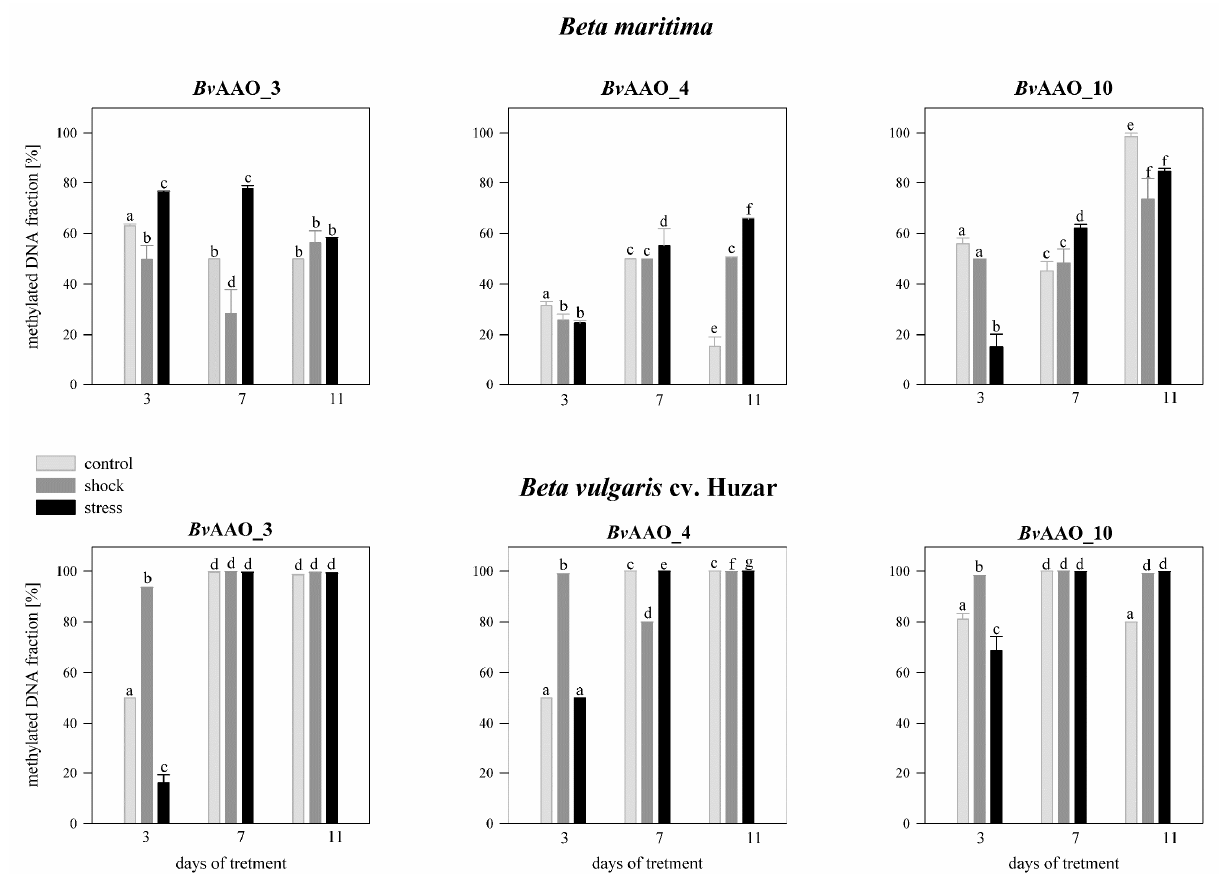
Figure 7. Methylated DNA fraction [%] of CpG islands in the promoter region of AAO genes Bv AAO_3, Bv AAO_4 and Bv AAO_10 determined in leaves of Beta vulgaris ssp. maritima and Beta vulgaris cv. Huzar subjected to salt shock or stress. Control − light gray bars, salt shock − gray bars, salt stress − black bars. Different letters denote significant differences at p < 0.01 (ANOVA followed by Tukey’s test). “Whiskers” indicate standard deviation.